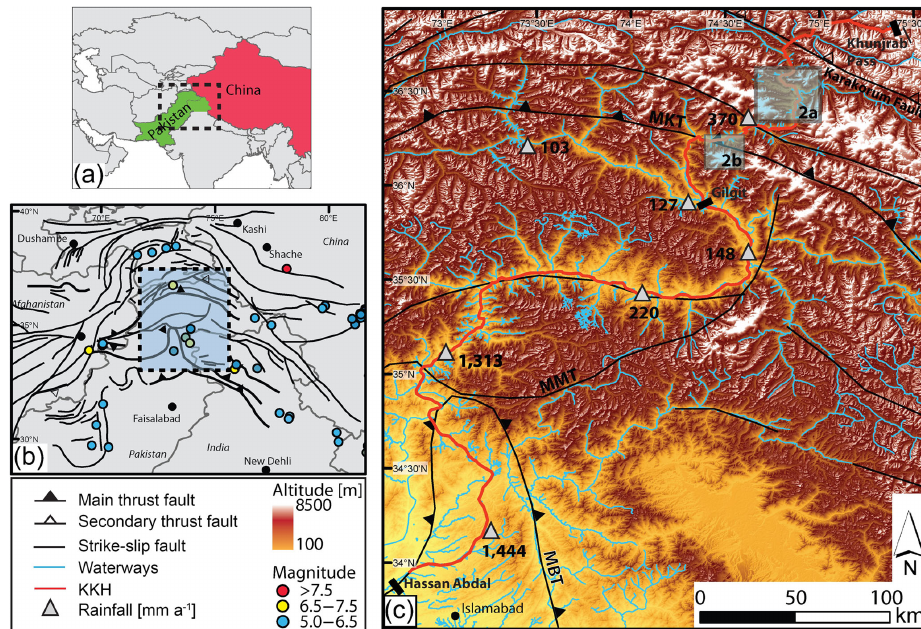
Figure 1. Overview of tectonics and precipitation in the study area. (a) Location of the study area in the region. (b) Active faults and major earthquake events in the region (USGS Earthquake Catalog, 2017). (c) Locations of the weather stations with mean annual rainfall (Pakistan Meteorological Department) and overview of tectonics and topography of the study area (After Hodges 2000): boxes 2a and 2b represent locations of Fig. 2. KKH it the Karakoram Highway, MBT is main boundary thrust, MMT is main mantle thrust, MKT is main Karakoram thrust (modified after Ali et al., 2017).